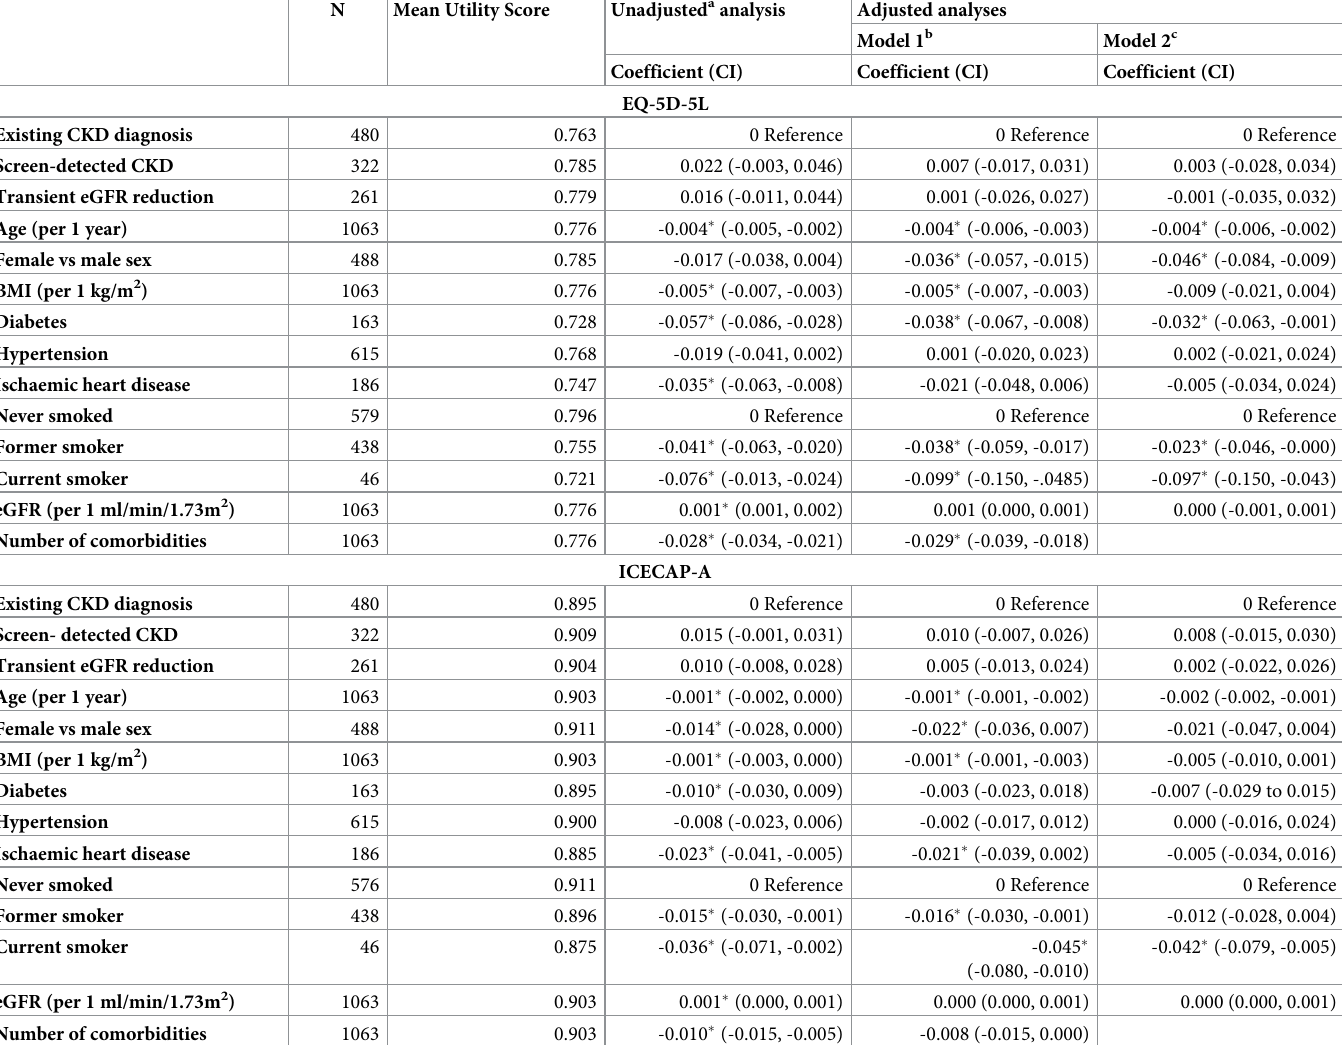
Table 3. Unadjusted and adjusted estimates of the association of CKD subgroup and other covariates with QoL utility score. N Mean Utility Score Unadjusted a analysis